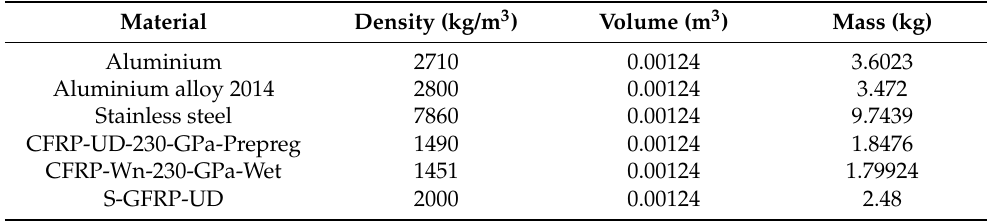
Table 3. Weight of US for appropriate material.